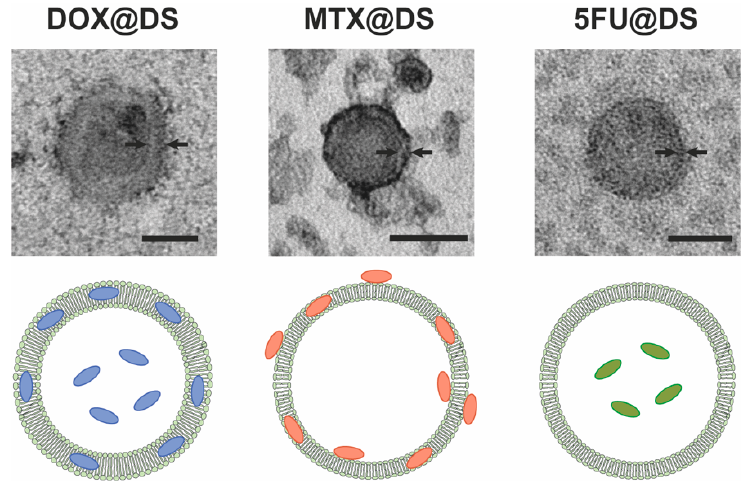
Figure 4. Representative TEM images of doxorubicin-loaded (DOX@DS), methotrexate-loaded (MTX@DS) and 5-fluorouracil-loaded (5FU@DS) dendrimersomes (top) and cartoons showing tentative drug distribution in dendrimersomes (bottom). Scale bar represents 50 nm. Black arrows show the thickness of a bilayer.